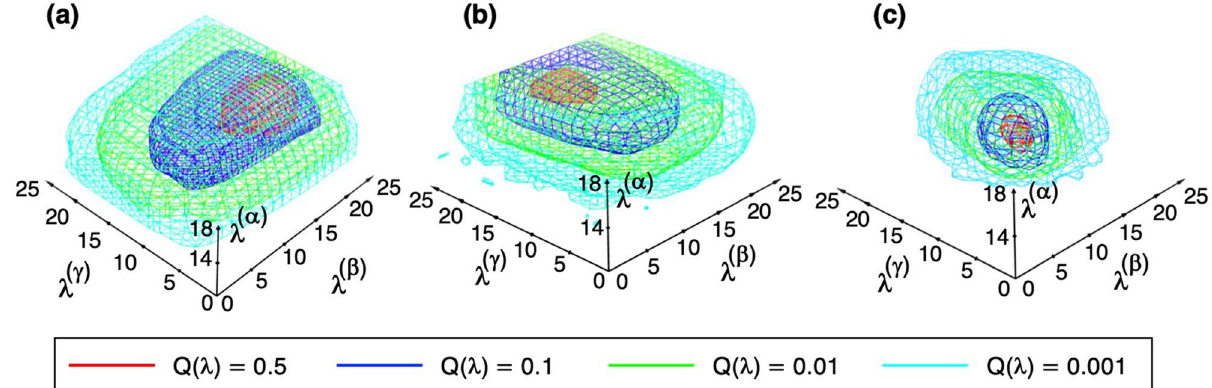
Figure 1. Density Q cano of ( a ) the sertraline–mSin3B, ( b ) YN3–mSin3B, and ( c ) acitretin–mSin3B systems in the 3D-RC space. In GA-guided mD-VcMD, the distribution is defined originally by Q cano L (α) , L (β) , L (γ) , where L (α) , L (β) , and L (γ) are respectively indices to specify the positions (cid:31) (α) , (cid:31) (β) , (cid:31) (cid:30)